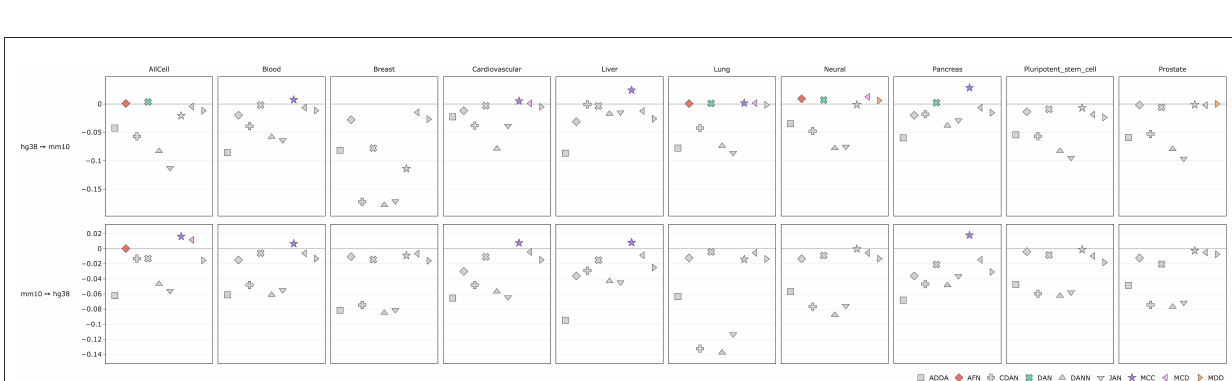
Overall direct cross-species predictions, with or without DA, work better for TFBS than for HM indicating the more conserved nature of sequences bearing TF binding